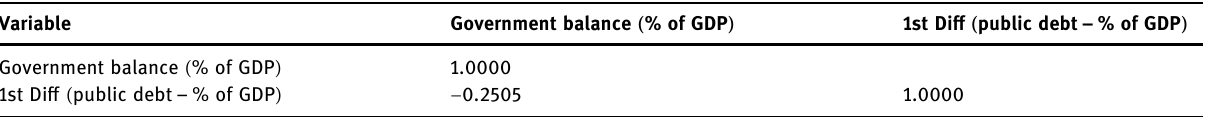
Table 8: Independent variable correlation Variable